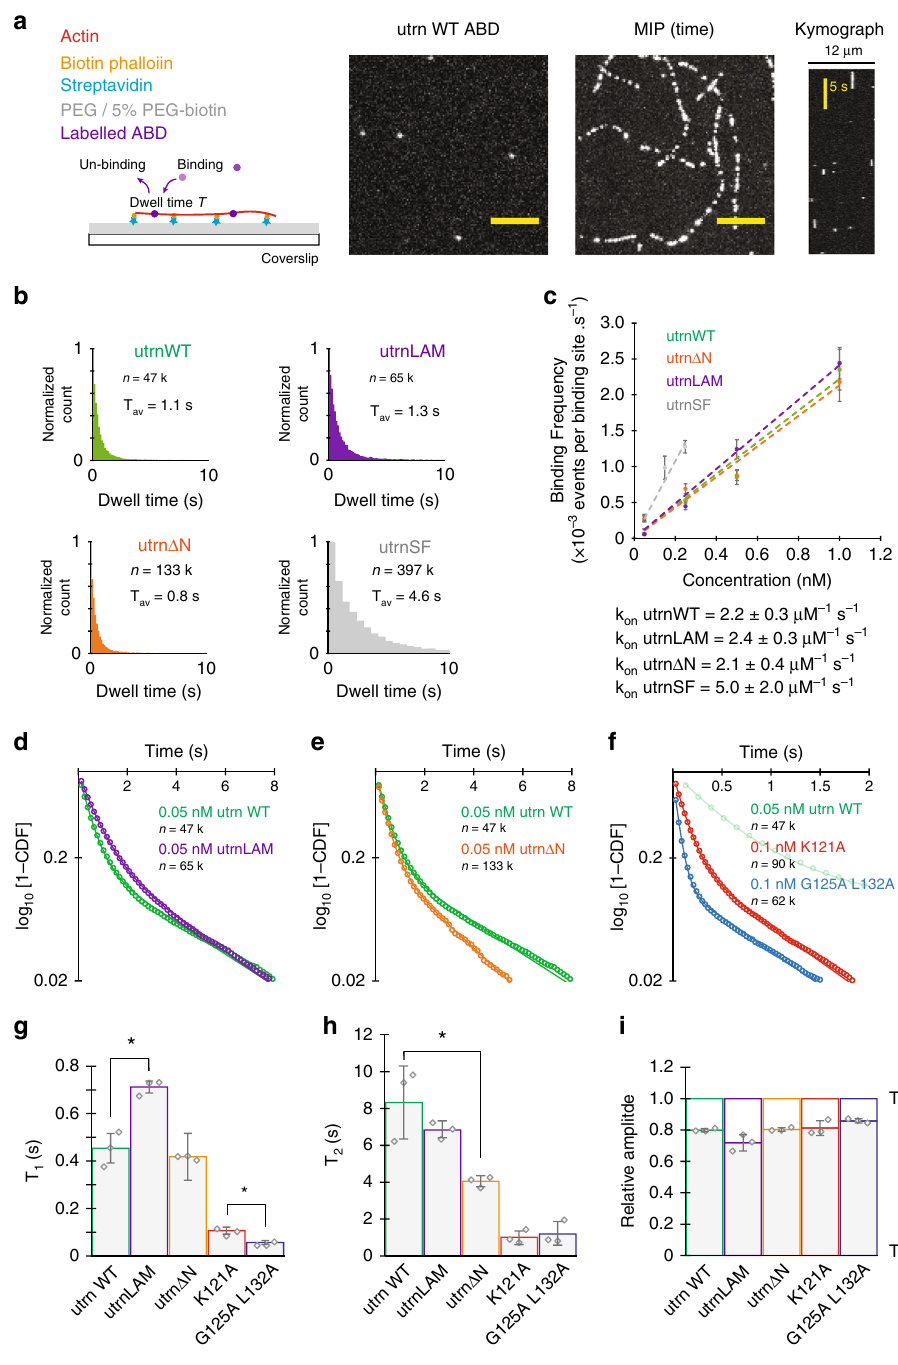
Fig. 2 Single molecule kinetic measurements of utrn CH1 – CH2 mutants in vitro. a Single molecule binding assay to measure the kinetic properties. Images in the example shown are for utrnWT. Maximum intensity projection through time displays the fi lament backbones and a kymograph the kinetics of binding. Scale bars are 5 µ m. The kymograph is a 12 µ m section of fi lament backbone. b Average binding dwell times for the different CH1 – CH2 mutants. c Binding on-rates for the different utrophin mutants evaluated by fi tting the binding event frequency over a range of different concentrations. Error bars are the mean ± SEM for each concentration measured from more than 12 fi elds of view collected from two imaging chambers. d Cumulative distribution function for utrnWT (green) and utrnLAM (magenta). e Cumulative distribution function for utrnWT (green) and utrn Δ N (orange). f Cumulative distribution function for K121A (red) and G125A L132A (blue). g Comparisons of the fi rst timescale τ 1 , h second timescale τ 2 , and i relative amplitude of events belonging to each timescale from a double exponential fi t to the cumulative distribution functions for the different constructs. Error bars are the standard deviation from the mean of 3 technical replicates. Conditions were compared using a two-tailed students t -test, with p < 0.05 denoted by a star